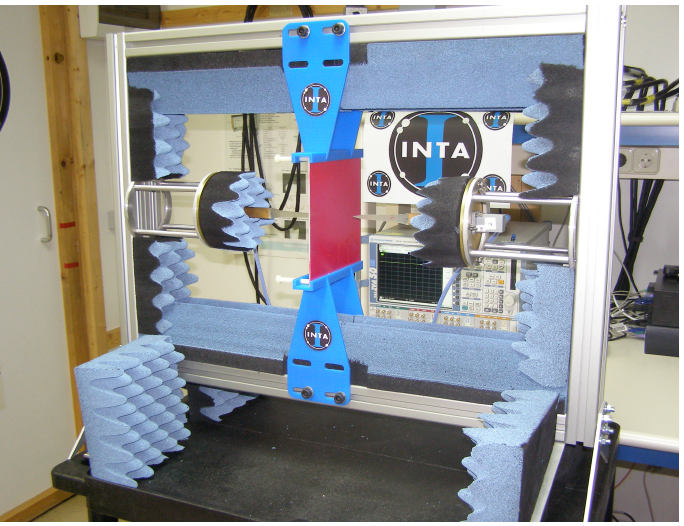
Figure 8. POLYBENCH. Measurement bench with high-precision polyrod